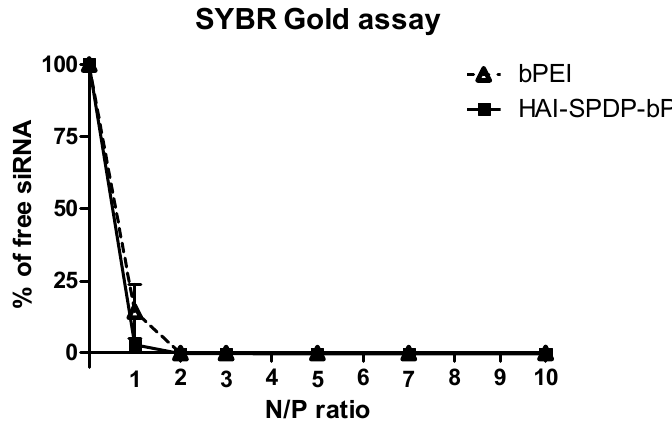
Figure 2. The siRNA condensation efficiency of bPEI and HAI-SPDP-bPEI was determined by a SYBR ® Gold assay at N/P ratio 1, 2, 3, 5, 7 and 10. At N/P = 0, the fluorescence represented 100% free siRNA. (Data points indicate mean ± standard deviation (SD), n = 3.)